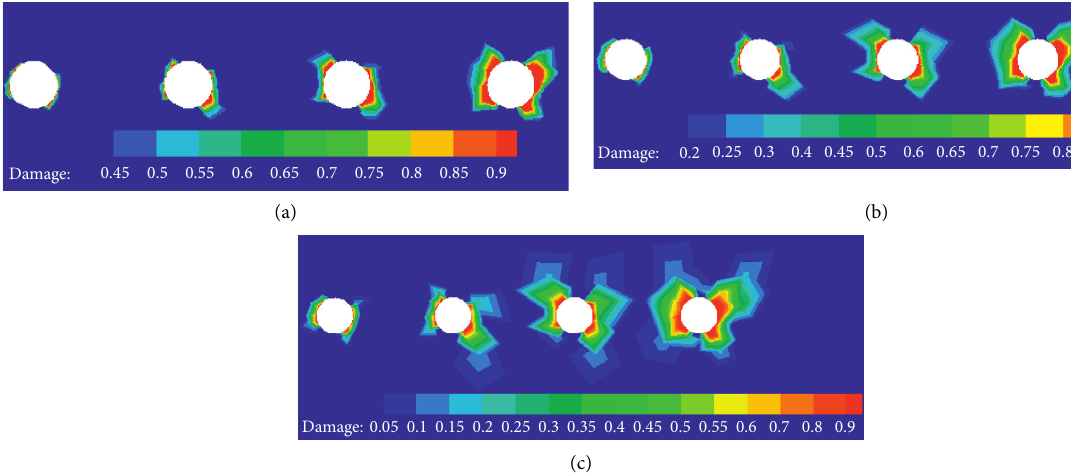
Figure 17: The damage zone under different hydraulic heads. (a) Hydraulic head (H) s � 50 m. (b) Hydraulic head (H) s � 80m. (c) Hydraulic head (H) s � 100m.